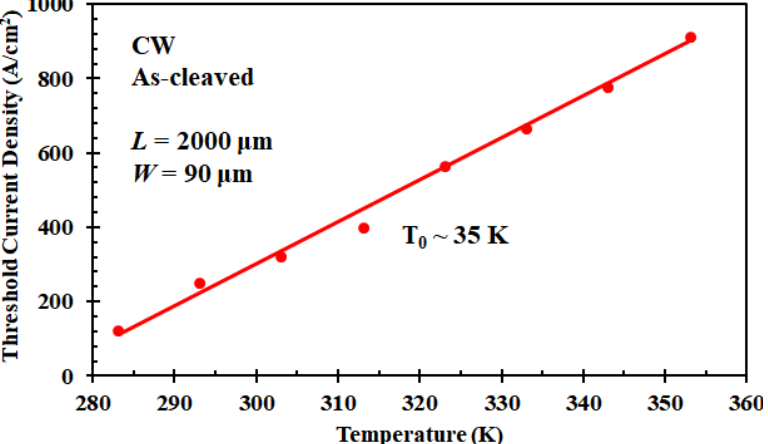
Figure 8. Characteristics of the temperature-dependent threshold current density of Si-based InAs/GaAs QD laser (characteristic